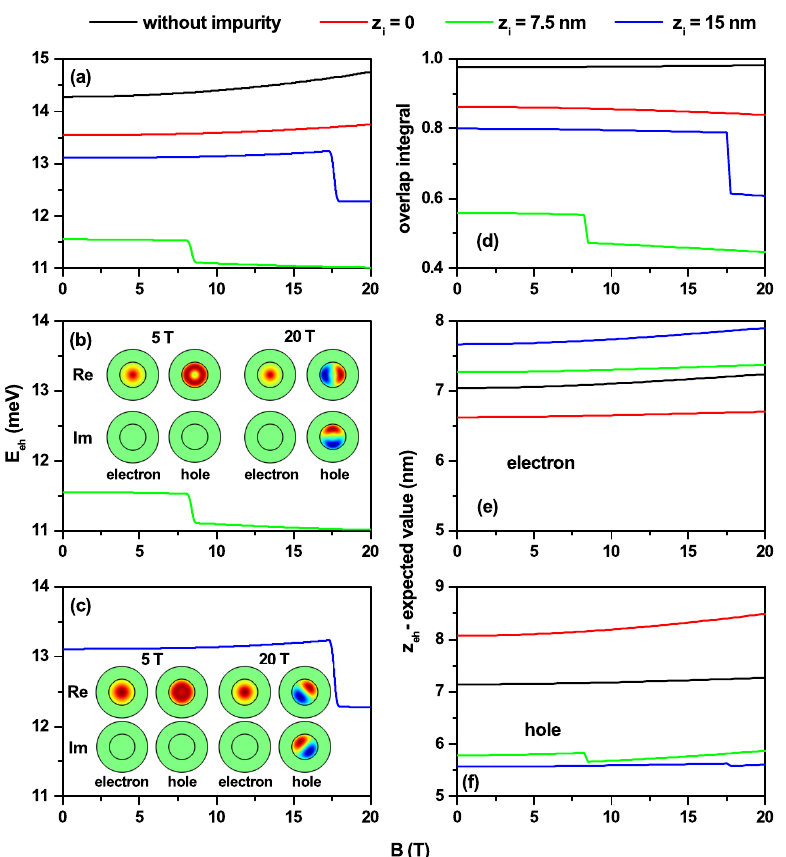
Figure 6. Characterization of the exciton effects in a truncated conical-shaped GaAs-Al 0.3 Ga 0.7 As quantum dot as functions of the vertically applied magnetic field. ( a ) e–h Coulomb energy with κ = 0 and κ (cid:54) = 0 with three impurity positions, ( b ) e–h Coulomb energy with the impurity at z i = 7.5 nm, ( c ) e–h Coulomb energy with the impurity at z i = 15nm, ( d ) overlap integral, ( e ) z e -average electron position, and ( f ) z h -average hole position. The results are for R 1 = 10 nm, R 2 = 20 nm, and h = 15 nm. Few electron and hole wavefunctions projections (real and imaginary parts) at the z = 7.5 nm plane are shown in panels ( b , c